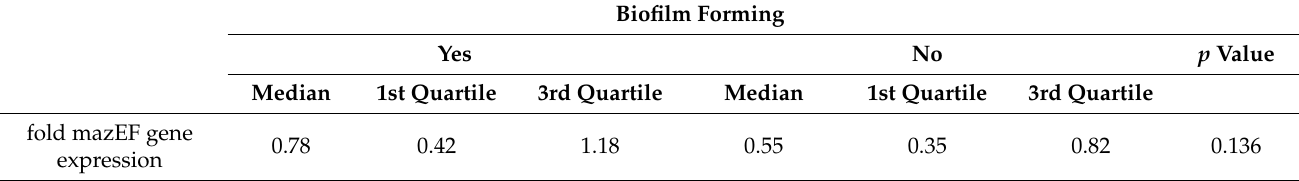
Table 3. The mazEF expression in relation to biofilm-formation.